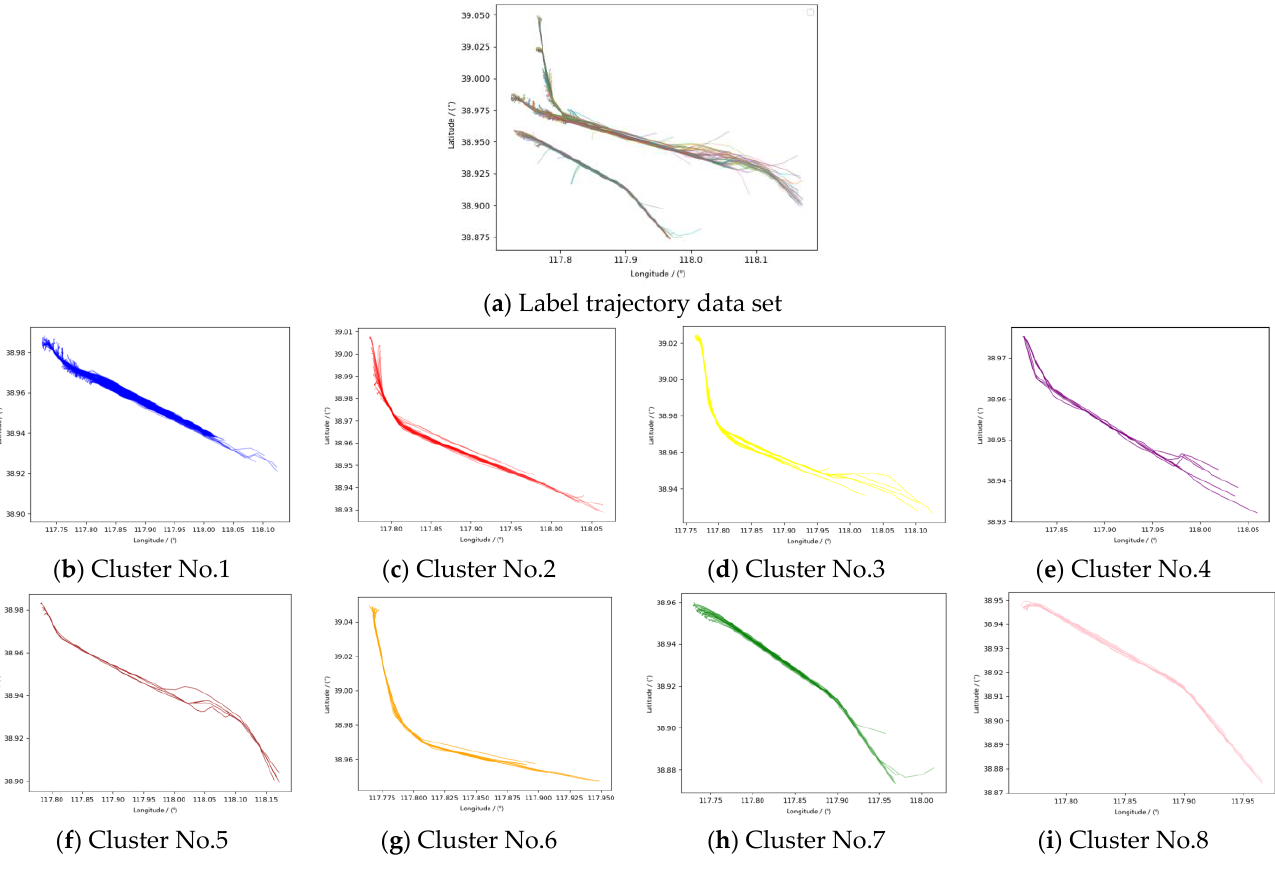
Figure 15. Clustering Experiment data.